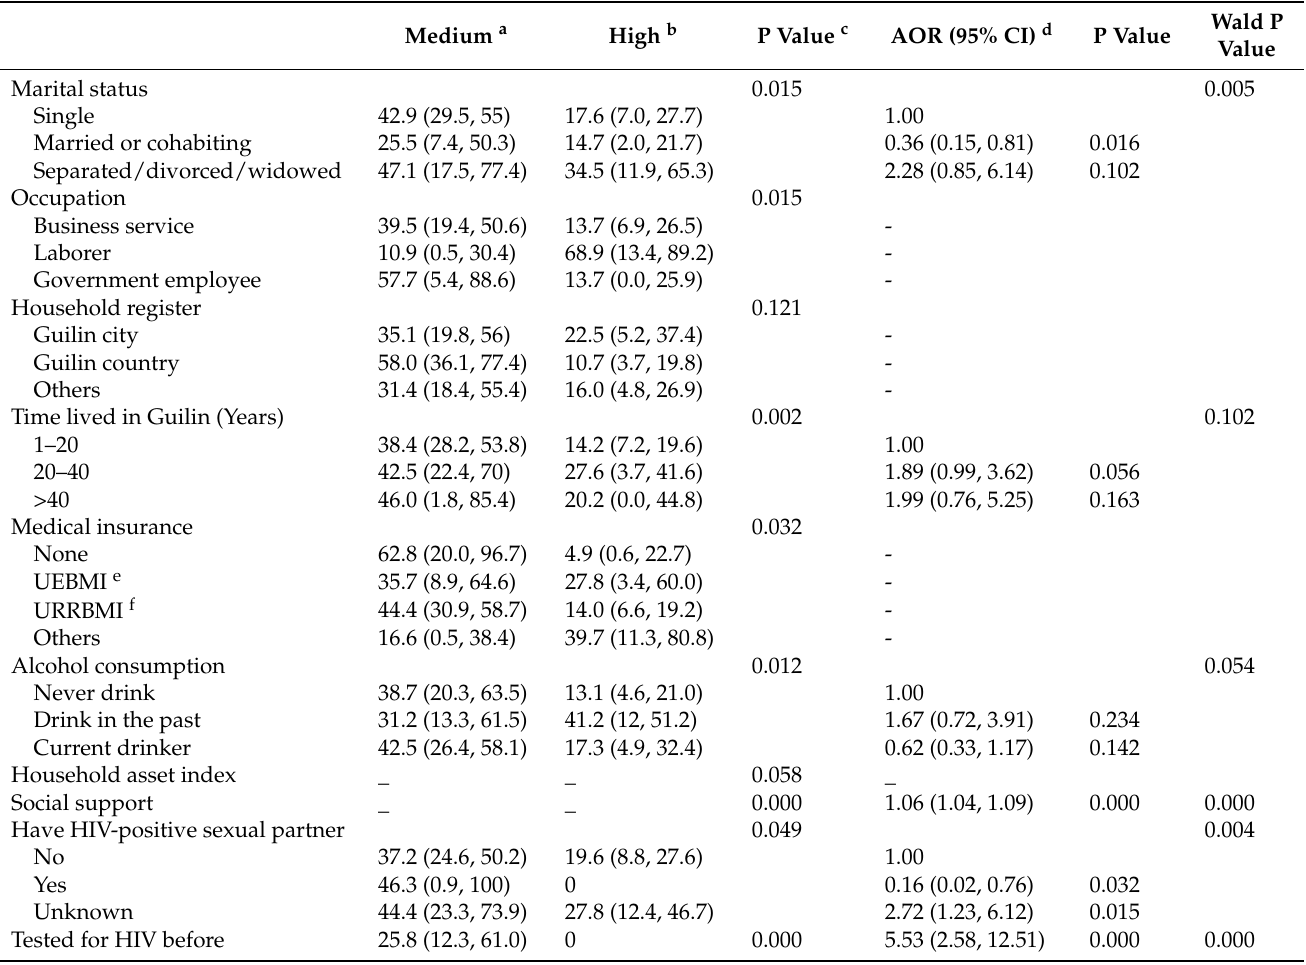
Table 6. Univariate and multivariate ordinal logistic regression of factors associated with acceptability of